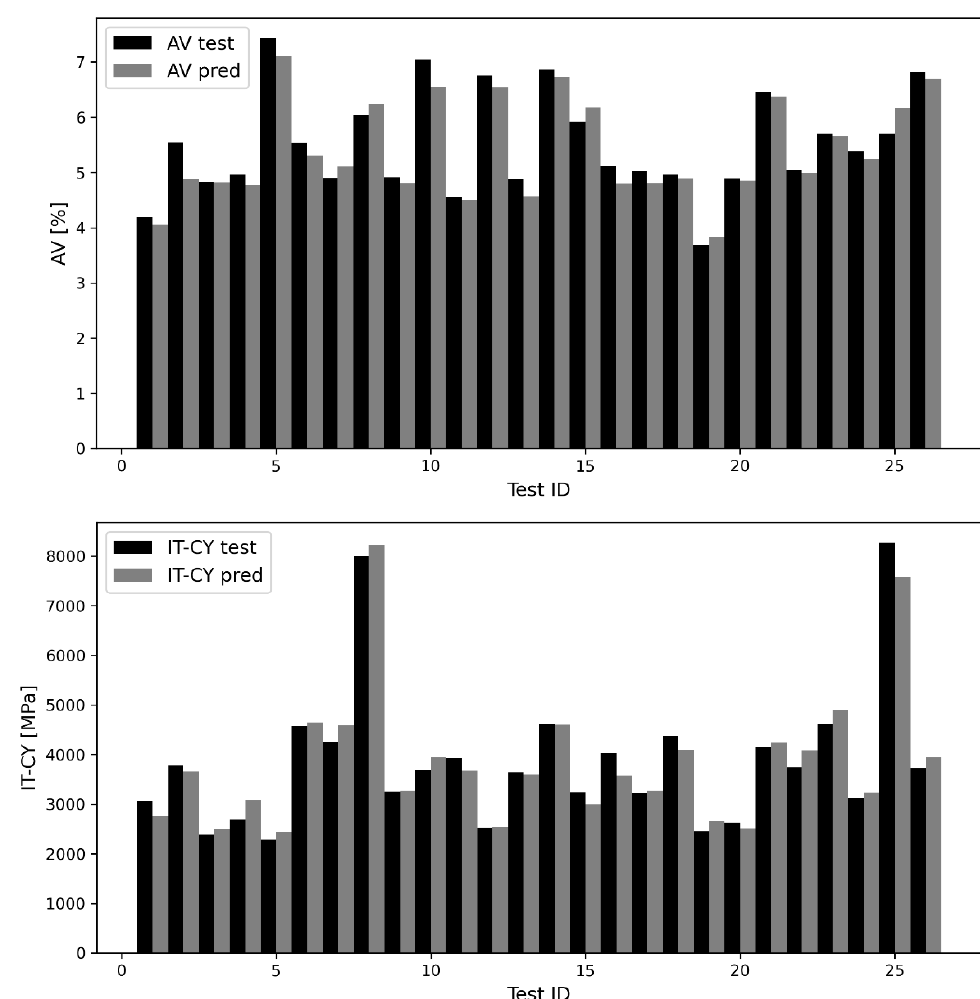
Figure 4. Test vectors and CatBoost-predictions of AV ( up ), and IT-CY ( down ) data.